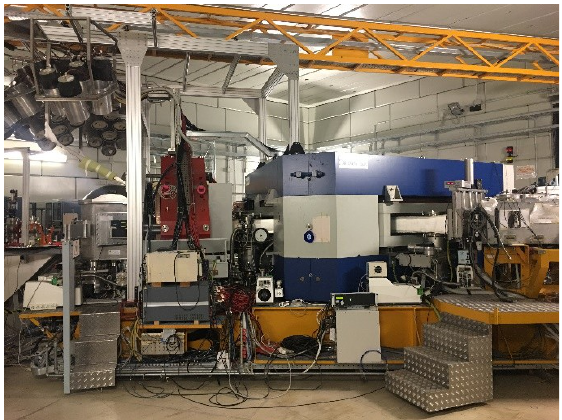
Fig. 1. View of the MAGNEX spectrometer at INFN-LNS